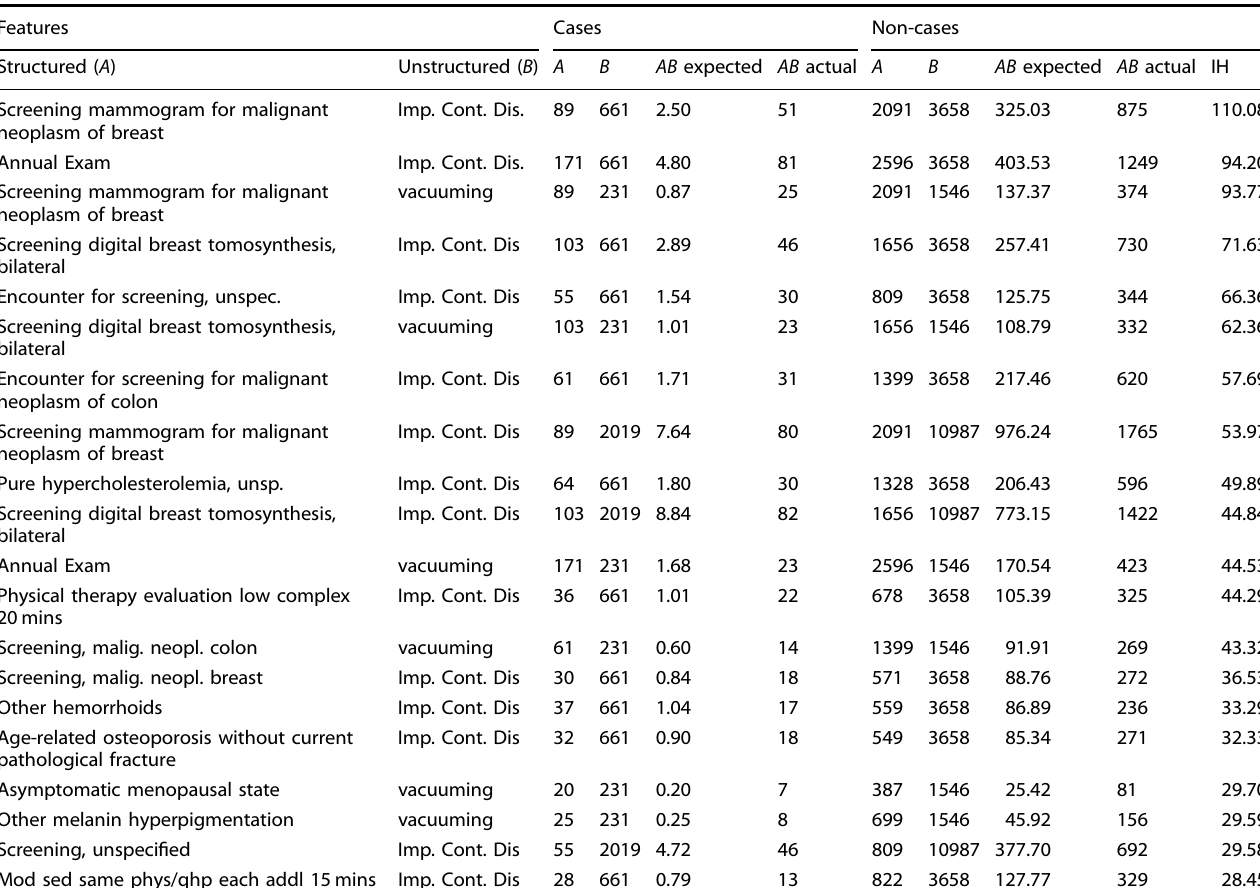
Table 5. Structured-unstructured feature pairs AB with high interaction heterogeneity (IH), where A is a strong protective factor against suicide.